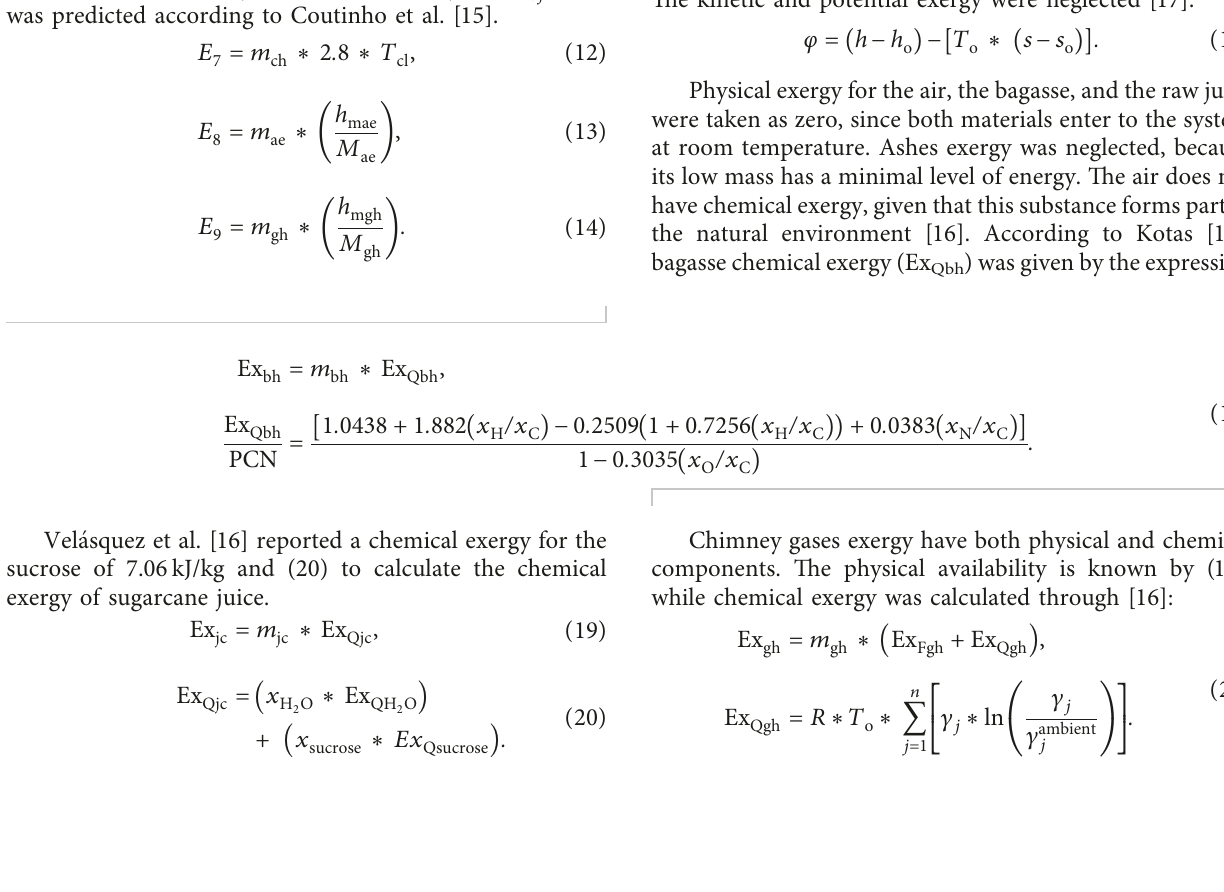
Figure 3: Energy balance in traditional furnace for making panela , energy in kJ. E contaminants in the sugarcane juice, E 5 : flocculant extract, E 6 : noncentrifugal brown sugar produced, E 7 : mud, E 8 : steam released during the evaporation, E 9 : chimney gases, and E 10 : other energy